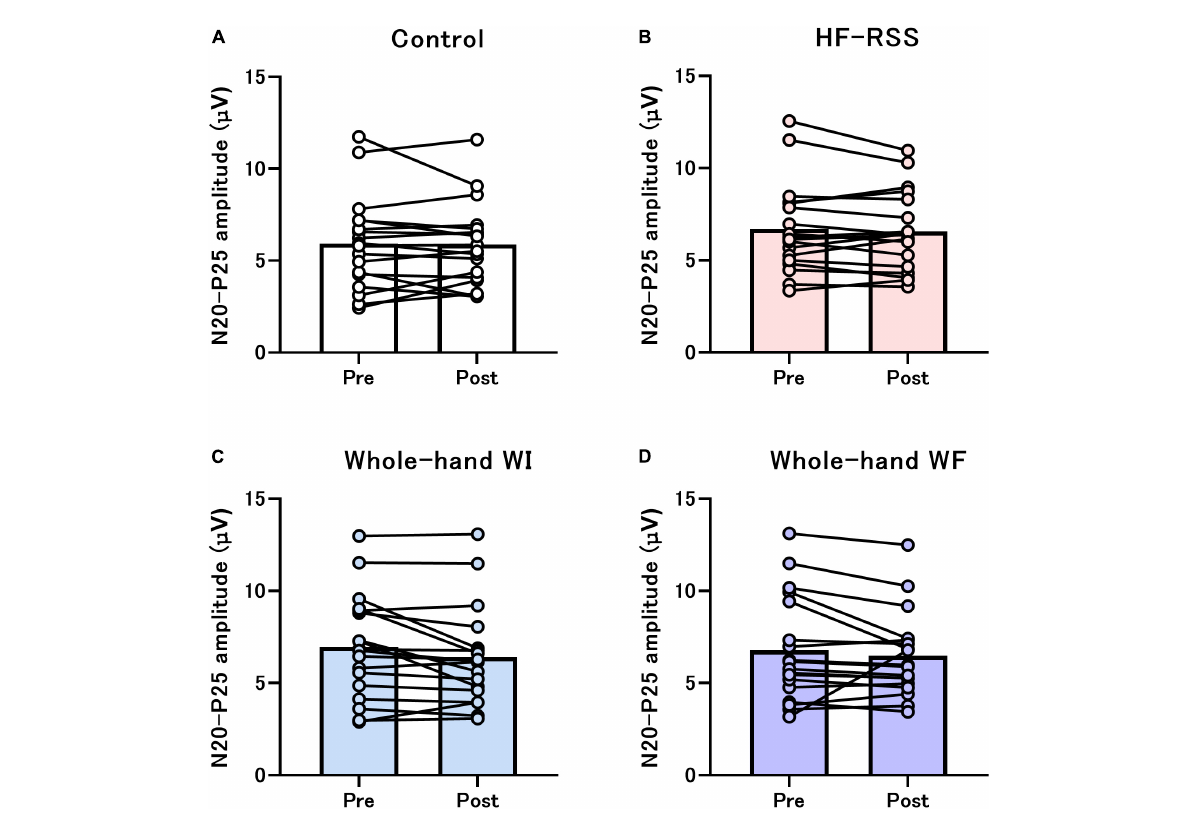
FIGURE4 Single-pulse N20-P25 amplitude before and after each intervention: (A) Control, (B) HF-RSS, (C) Whole-hand WI, and (D) Whole-hand WF. Generalized linear mixed model revealed that there was no significant interaction or main effect of “intervention” and “time,” except for the main effect of “intervention.” HF-RSS, high-frequency repetitive somatosensory stimulation.